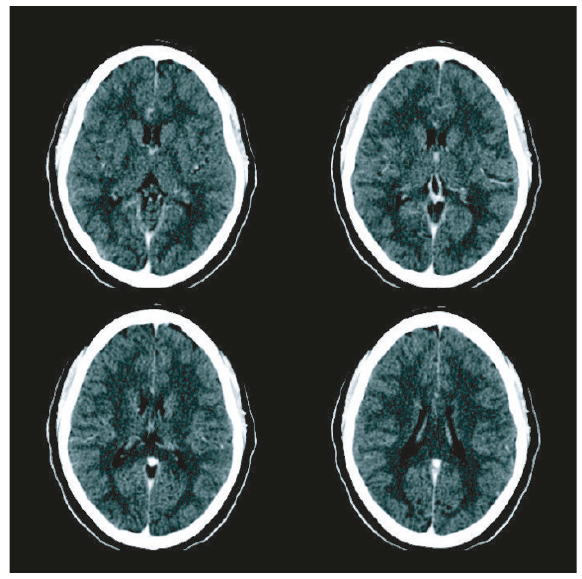
Figure 1: Four views of a tomographic image of the brain. The in- tensity is related to the density. Each slice corresponds to a certain elevation in the